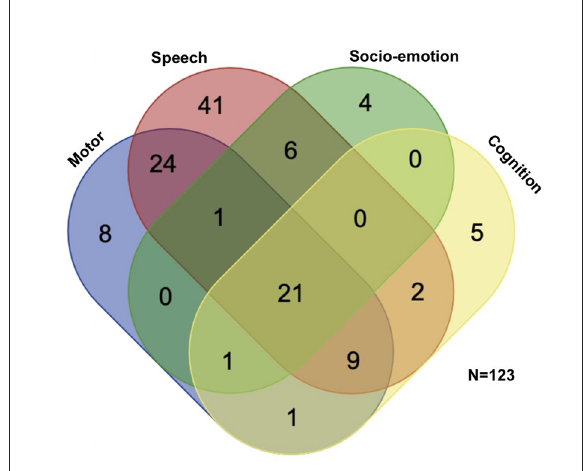
FIGURE1 Participants’ distribution of different domains of neurodevelopmental delay. Selecting the most common four domains of developmental delay, more than half ( n = 65, 53%) of the children with developmental delay had mixed developmental delay. Speech developmental delay was the most prevalent ( n = 104, 85%), followed by motor developmental delay ( n = 65, 53%), cognitive developmental delay ( n = 39, 32%), and socio-emotional delay ( n = 33,